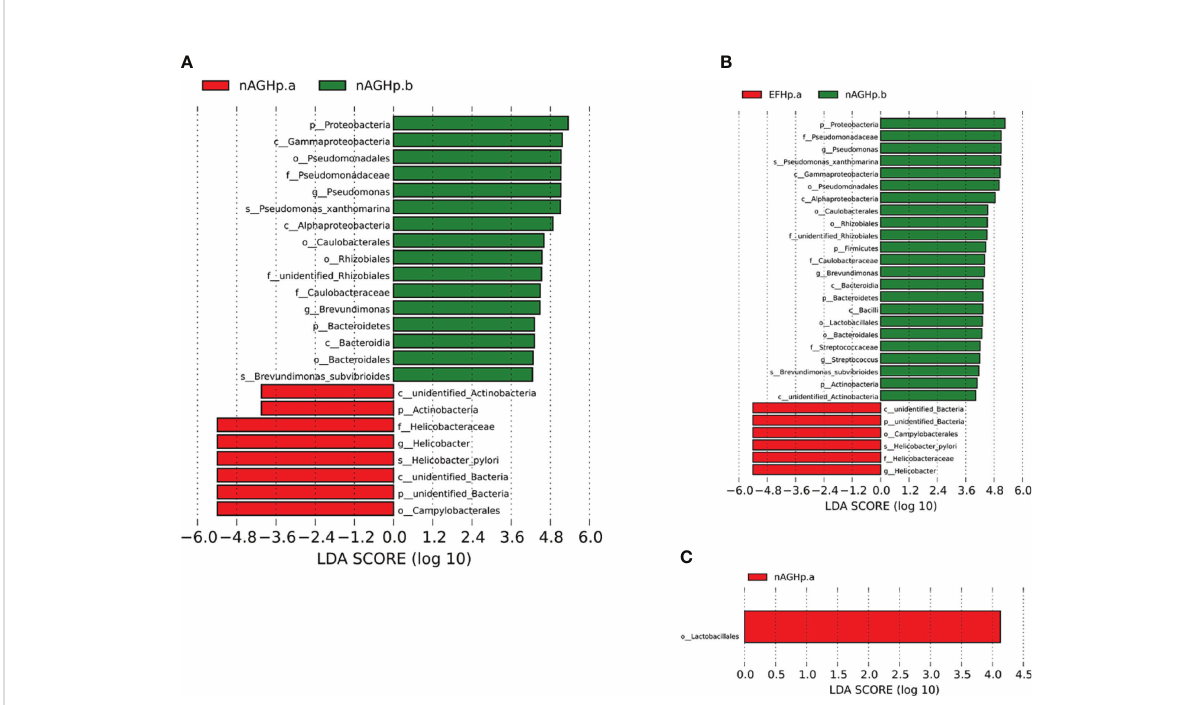
FIGURE 5 Identi fi cation of differential bacteria by LEfSe analysis. (A) Group nAGHp.a VS. Group nAGHp.b. (B) Group EFHp.a VS. Group nAGHp.b. (C) Group nAGHp.a VS. Group EFHp.a. nAGHp.a, treatment-naïve patients with H . pylori infection; nAGHp.b, H . pylori -negative patients; EFHp.a, patients with refractory H. pylori